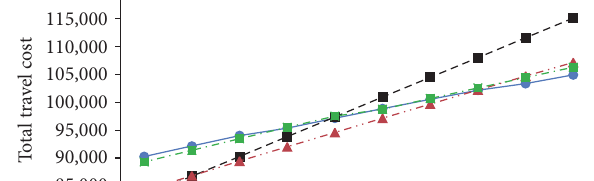
Table 3: Performance of scenarios.